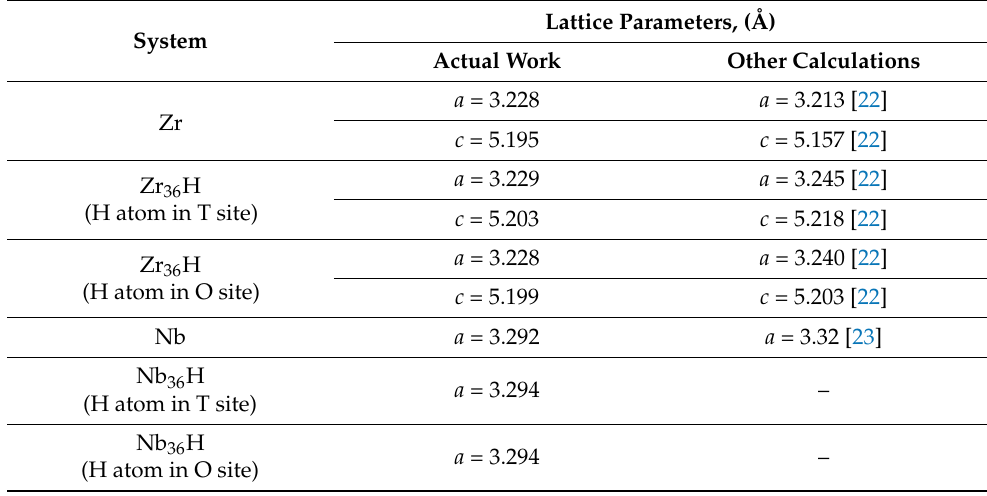
Table 1. The theoretical lattice parameters of pure Zr and Nb, Zr 36 H and Nb 36 H solid solutions. Lattice Parameters, (Å) System